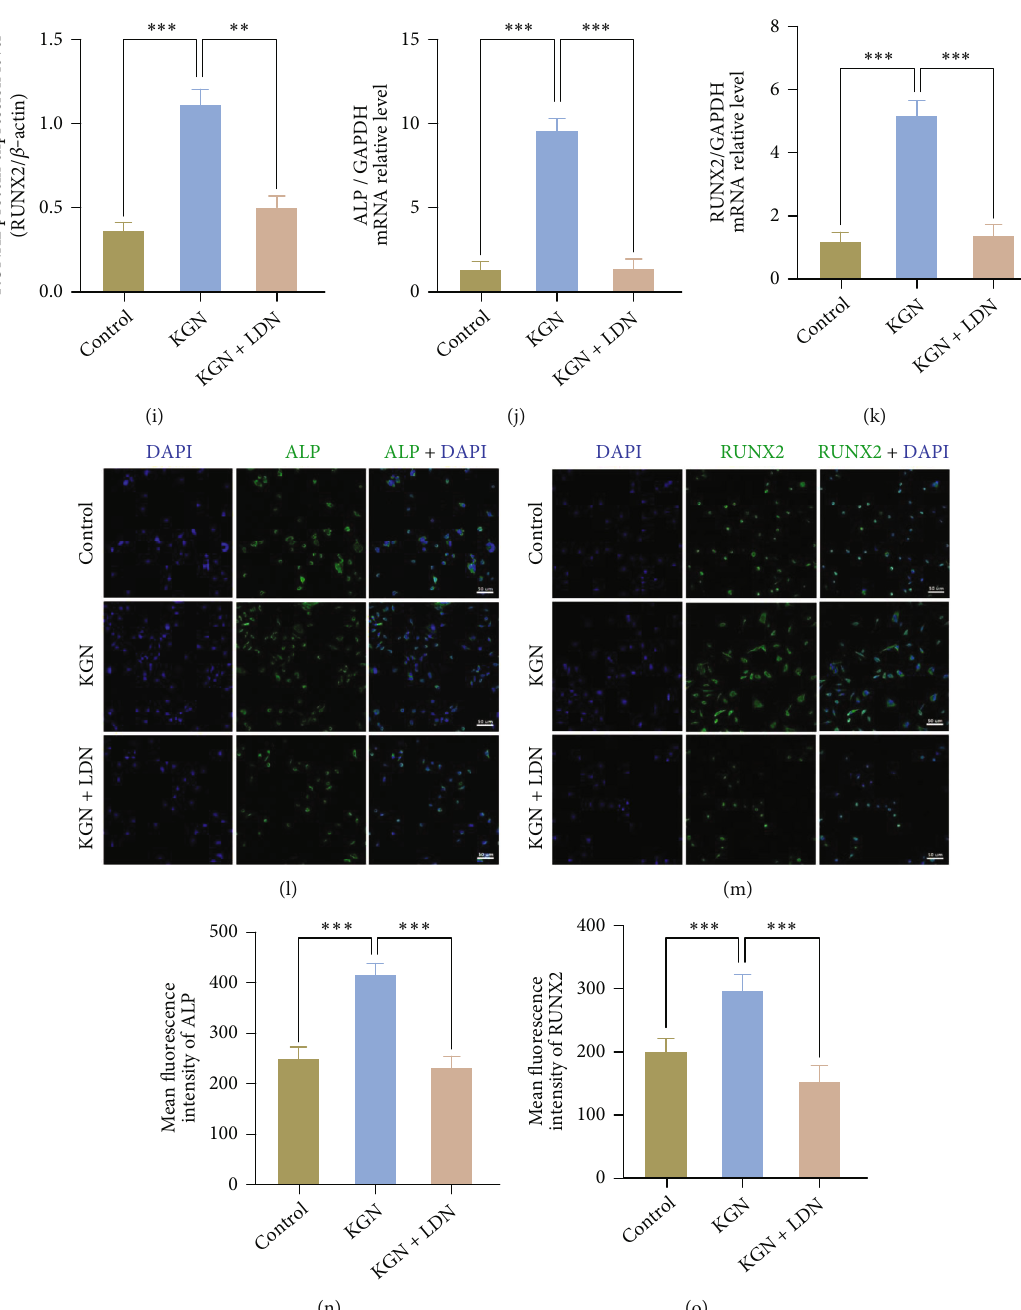
Figure 4: KGN elevates autophagic activities in BMMSCs and prompts osteogenesis through Smad1/5/9 signal pathway. Western blotting (a) and semiquanti fi cation (b) of Smad and phosphorylation level of Smad1/5/9. 3-MA-mediated autophagy suppression inhibited KGN- induced Smad1/5/9 phosphorylation increase. ∗∗∗ p < 0 : 001 , one-way ANOVA test. Western blotting (c) and semiquanti fi cation (d) of the phosphorylation level of Smad1/5/9 in the control and LDN-treated BMMSCs. LDN e ff ectively inhibited phosphorylation level of Smad 1/5/9. ∗∗ p < 0 : 01 , independent Student ’ s t test. ARS detection (e) and semiquanti fi cation (f) of mineralized nodules. LDN inhibited KGN-induced osteogenesis. Scale bar = 500 μ m. ∗ p < 0 : 05 and ∗∗∗ p < 0 : 001 , one-way ANOVA test. (g) Western blotting, (h, i) semiquanti fi cation of (g), and (j, k) qRT-PCR assay of ALP and Runx2. LDN inhibited KGN-induced expression of osteogenic genes. ∗∗ p < 0 : 01 and ∗∗∗ p < 0 : 001 , one-way ANOVA test. (l, m) Detection of ALP (green), Runx2 (green), and DAPI (blue) by immuno fl uorescent staining in BMMSCs. (n, o) Semiquanti fi cation of (l) and (m). LDN inhibited KGN-induced expression of osteogenic genes. Scale bar = 50 μ m. ∗∗∗ p < 0 : 001 , one-way ANOVA